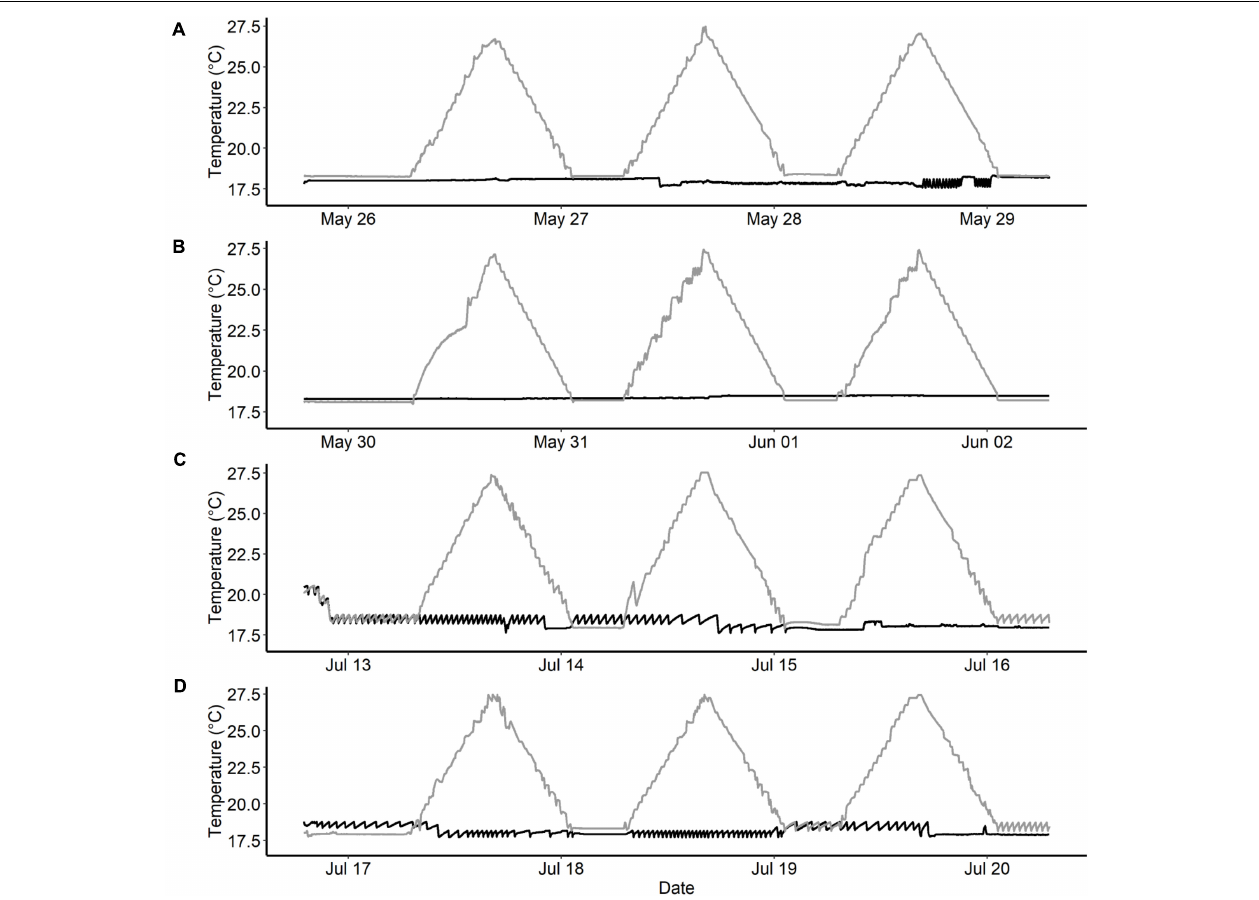
FIGURE 3 | Temperature recording from temperature loggers (HOBO: Water temp pro v2) that measured water temperature once every minute during water thermal spike studies in Chinook salmon. Black lines represent the constant temperature groups ( ∼ 18 ◦ C) and the gray line represents the spike groups (+9 ◦ C per day). (A,B) —represents replicate rounds for fish reared at elevated temperatures, and (C,D) —represents replicate rounds for fish reared at current